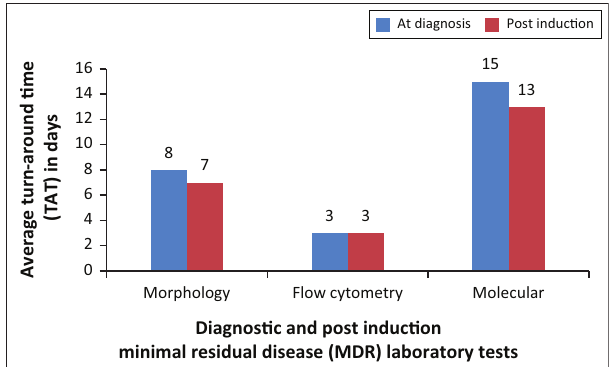
FIGURE 4: Comparison of turn-around times.